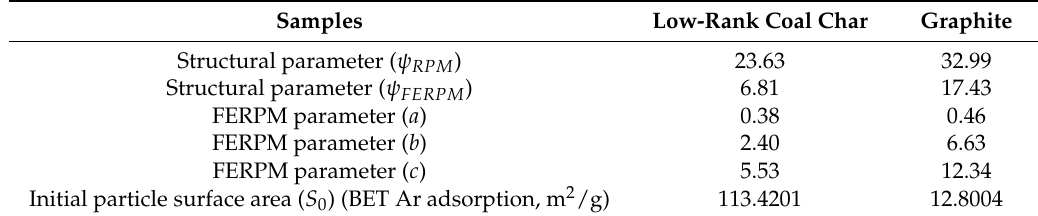
presented in Figure 5.